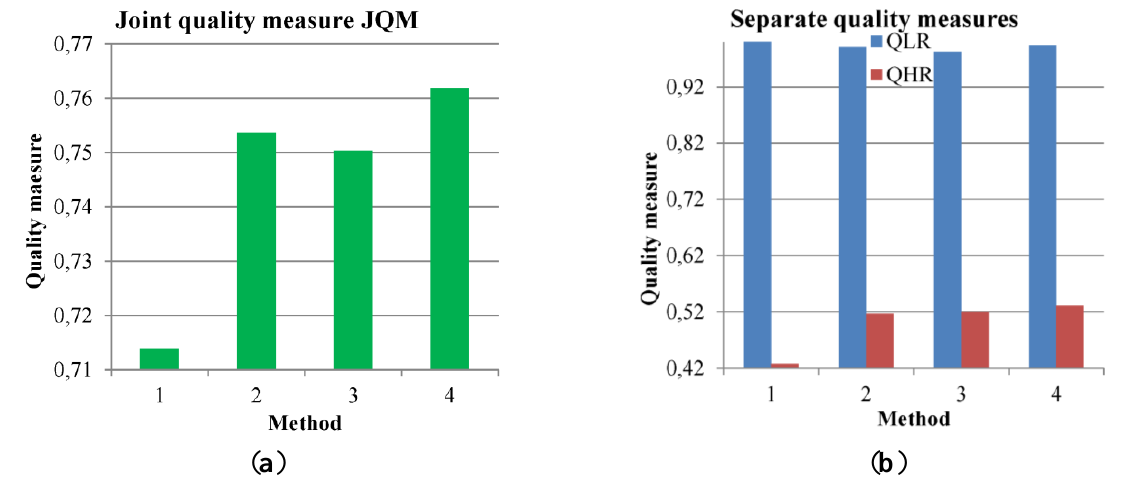
Figure 1. Joint Quality Measure (JQM) quality assessment of interpolation methods: 1—nearest neighbor (NN), 2—zero padding (ZP), 3—bilinear interpolation (BIL), and 4—cubic convolution (CUB) for IKONOS data. ( a ) JQM, ( b ) QLR and